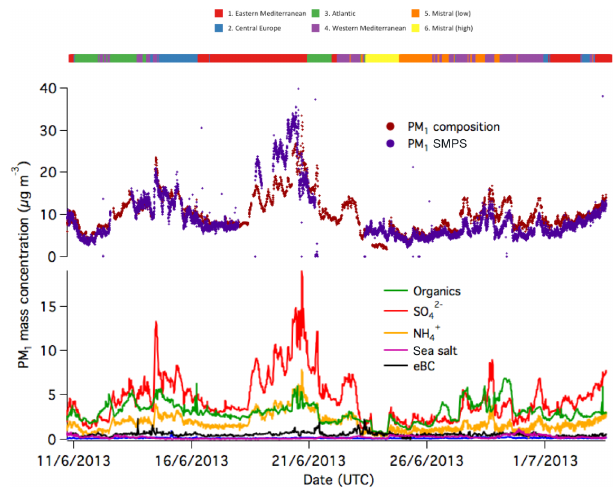
Figure 5. The time series of PM 1 mass concentration, coloured by the relative contribution from each species. The top bar is coloured according to the air-mass origin.